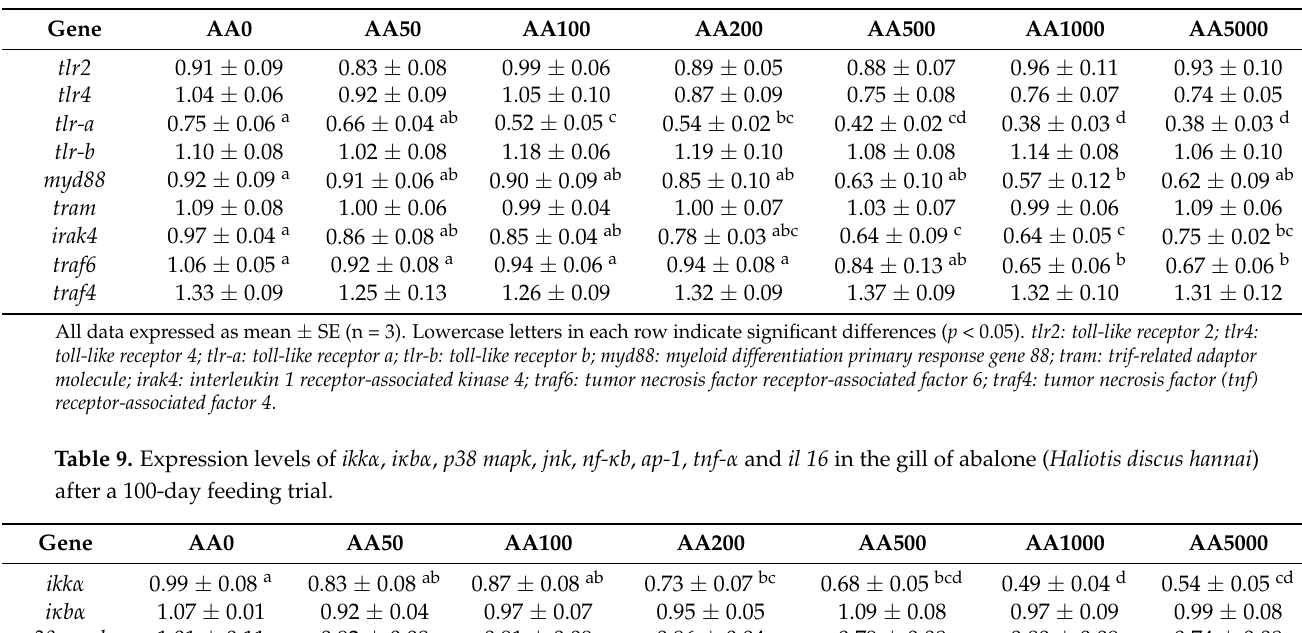
Figure 2. Protein expressions of MyD88, JNK, mature IL-1 β and nuclear NF- κ B p65 in the digestive gland of abalone ( Haliotis discus hannai) after a 100-day feeding trial. ( A ) Representative Western Blot image of MyD88, JNK, mature IL-1 β and nuclear NF- κ B p65; ( B – E ) Protein expressions of MyD88, JNK and mature IL-1 β and nuclear NF- κ B p65. All data are expressed as the mean ± SE ( n = 3). The different lowercase letters indicate significant differences ( p < 0.05). Table 8. Expression levels of tlr2 , tlr4 , tlr-a , tlr-b , myd88 , tram , irak4 , traf4 and traf6 in the gill of abalone ( Haliotis discus hannai ) after a 100-day feeding trial.